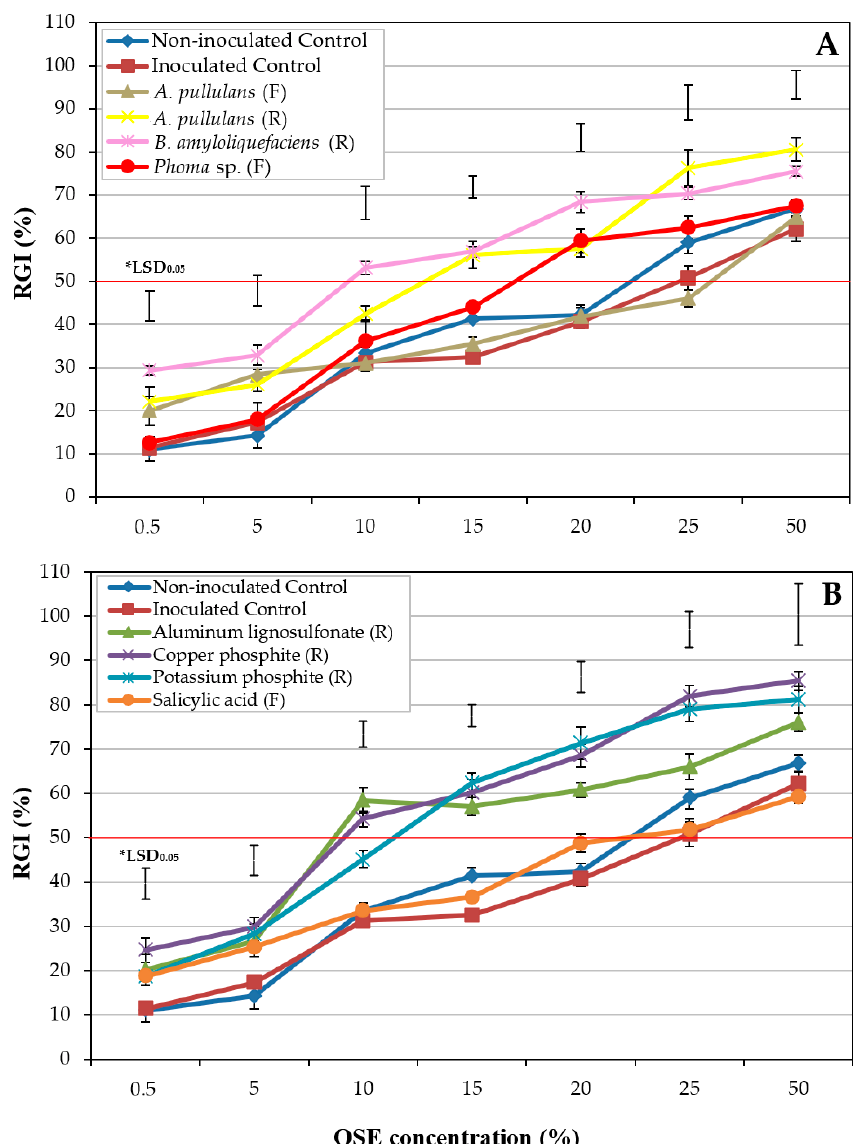
Figure 2. Effect of olive stem extract (OSE) from healthy olive plants of cv. Picual treated by foliar (F) or root (R) applications with ( A ) microorganisms (biological control agents) and ( B ) commercial products on the relative conidial germination inhibition (RGI) of Verticillium dahliae isolate V180. In each graph, data are the means of 240 conidia (six replicates) per combination of compound and OSE concentration. Vertical bars represent the standard error of the means. *LSD bars represent the critical values for comparison at P = 0.05.